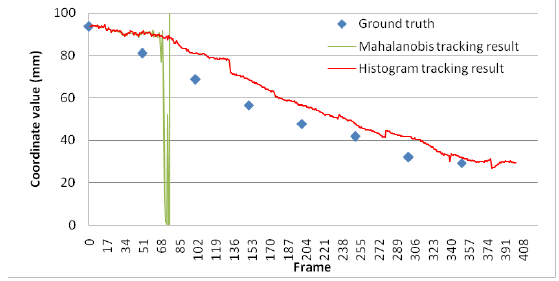
Figure 21. IPB tracking results of the camera axis for the coffee box real sequence.